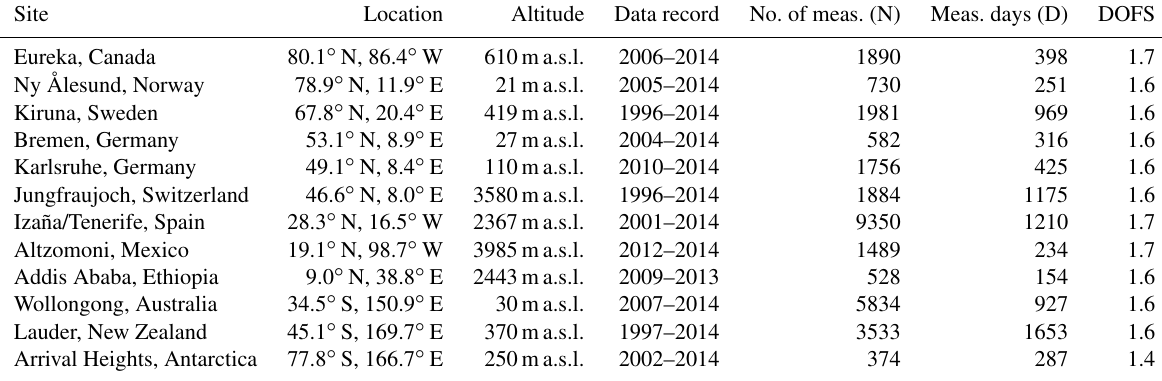
Table 4. List of current MUSICA NDACC/FTIR sites (ordered from north to south) and available MUSICA data record of quality-filtered data. DOFS (degrees Of freedom of signal) for the optimal estimation of {H 2 O, δ D} pairs (trace of A ∗ blocks is plotted in Fig. 1). This table is adopted from Barthlott et al. (2016a). Site Location Altitude Data record No. of meas. (N) Meas. days (D)